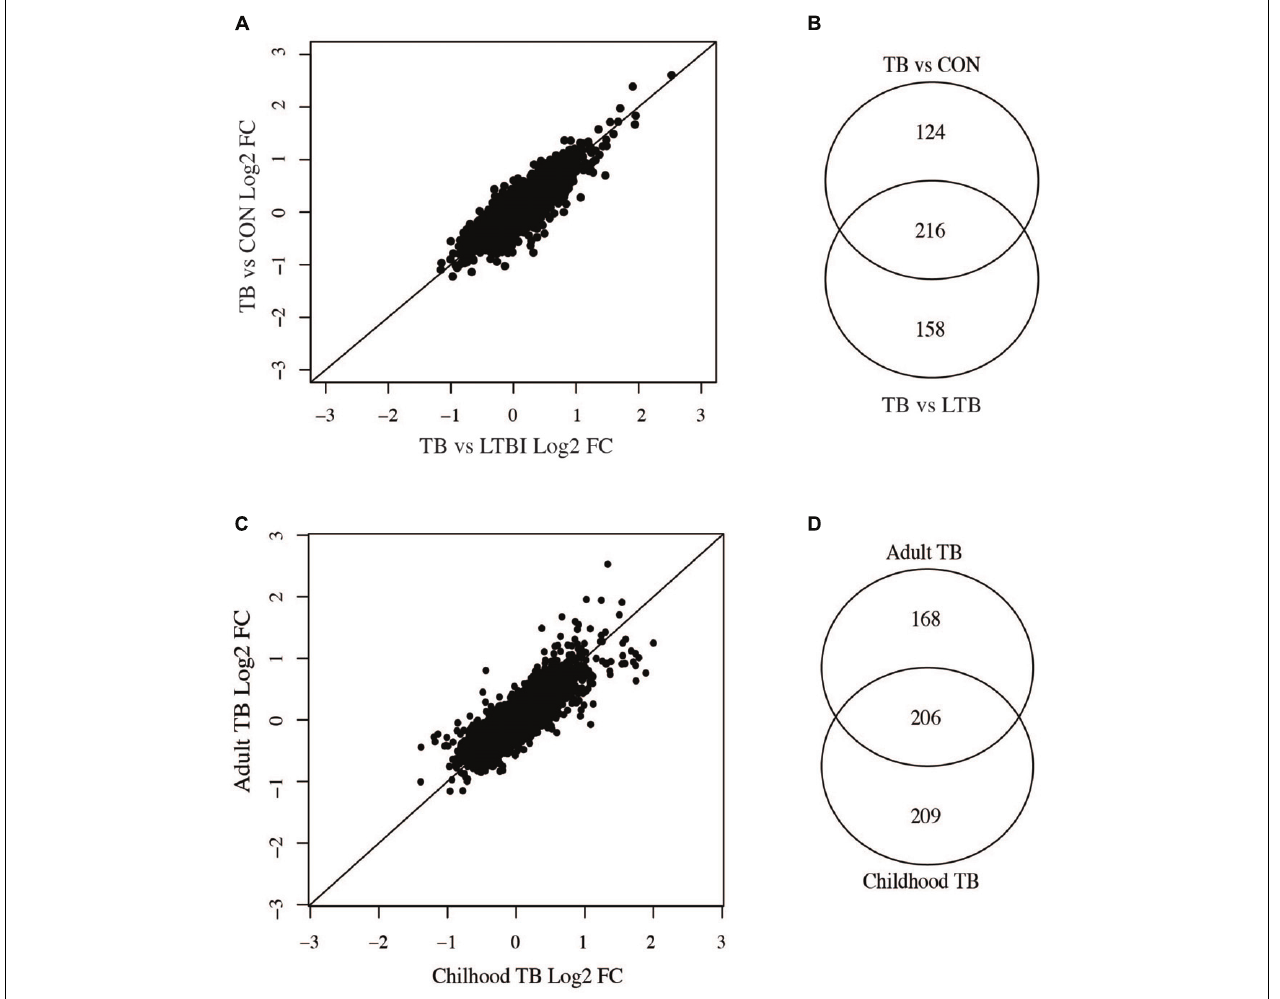
FIGURE 5 | Comparisons of adult active TB versus LTBI and controls and childhood versus adult TB. (A) Correlation between adult active TB versus latent TB and active TB versus uninfected controls. (B) Number of genes common between active TB versus latent and active TB versus uninfected controls. (C) Correlation of fold changes obtained in active versus latent TB in children and adults. (D) Overlap of differentially expressed genes in adult and childhood TB.